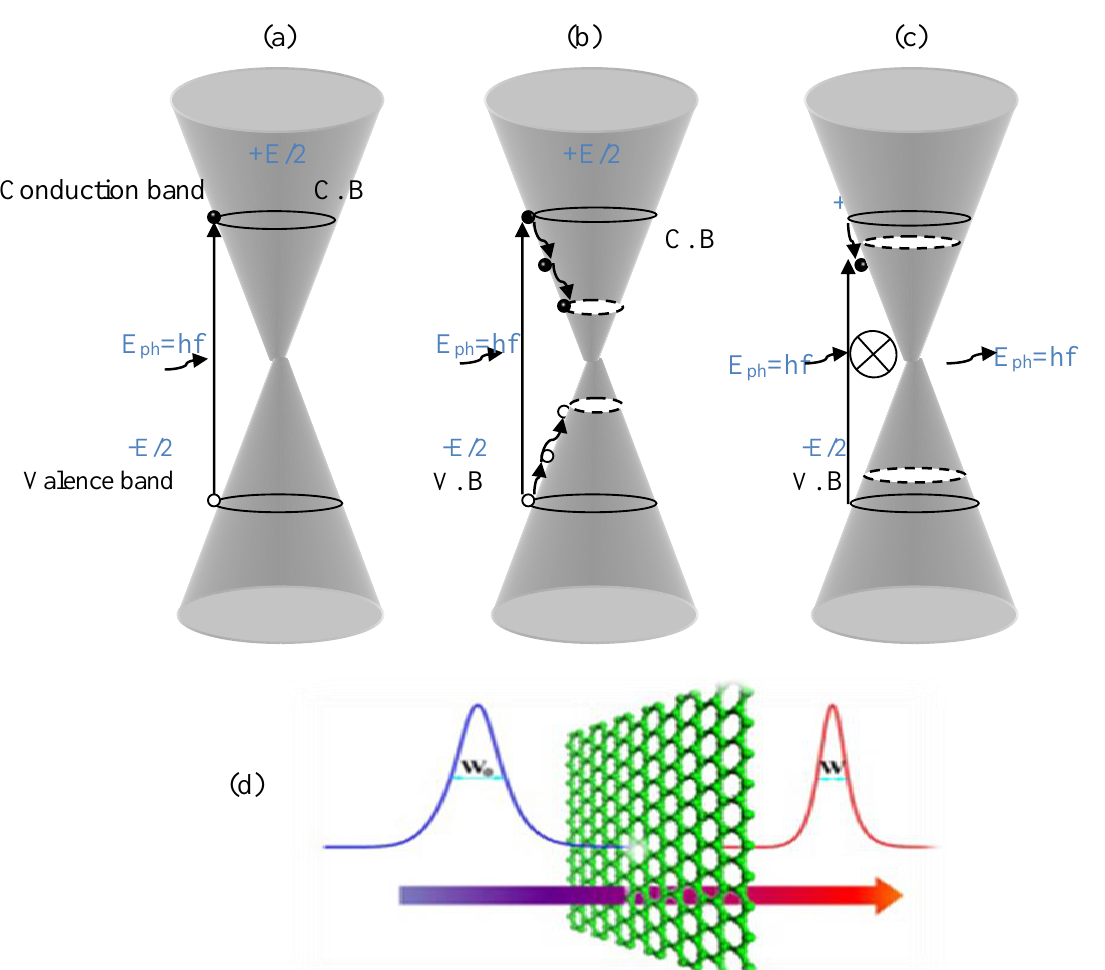
Fig.4: The mechanism of saturable absorption mode